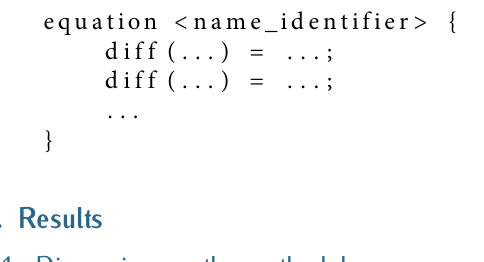
Figure 5. Representation of an equation-based model in an simulation